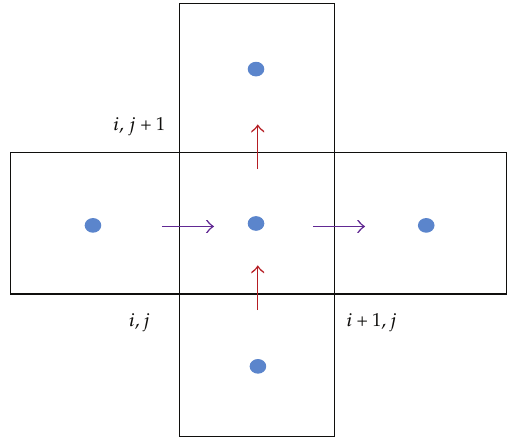
Figure 3: A generic cell for finite di ff erence